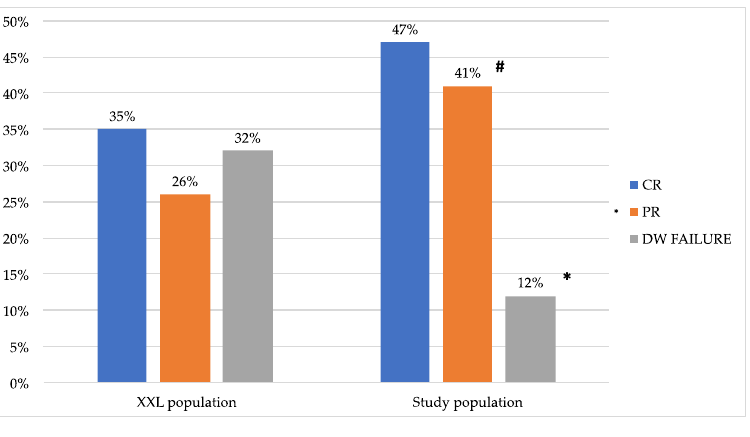
Figure 2. Effectiveness of downstaging in the study and in XXL populations. In five patients of the XXL group (7%), response to downstaging was not described (three developed contraindications to LT, while two withdrew consent) in the study [13]. These patients were not randomized. Abbreviations: CR, complete response; PR, partial response; DW, downstaging.